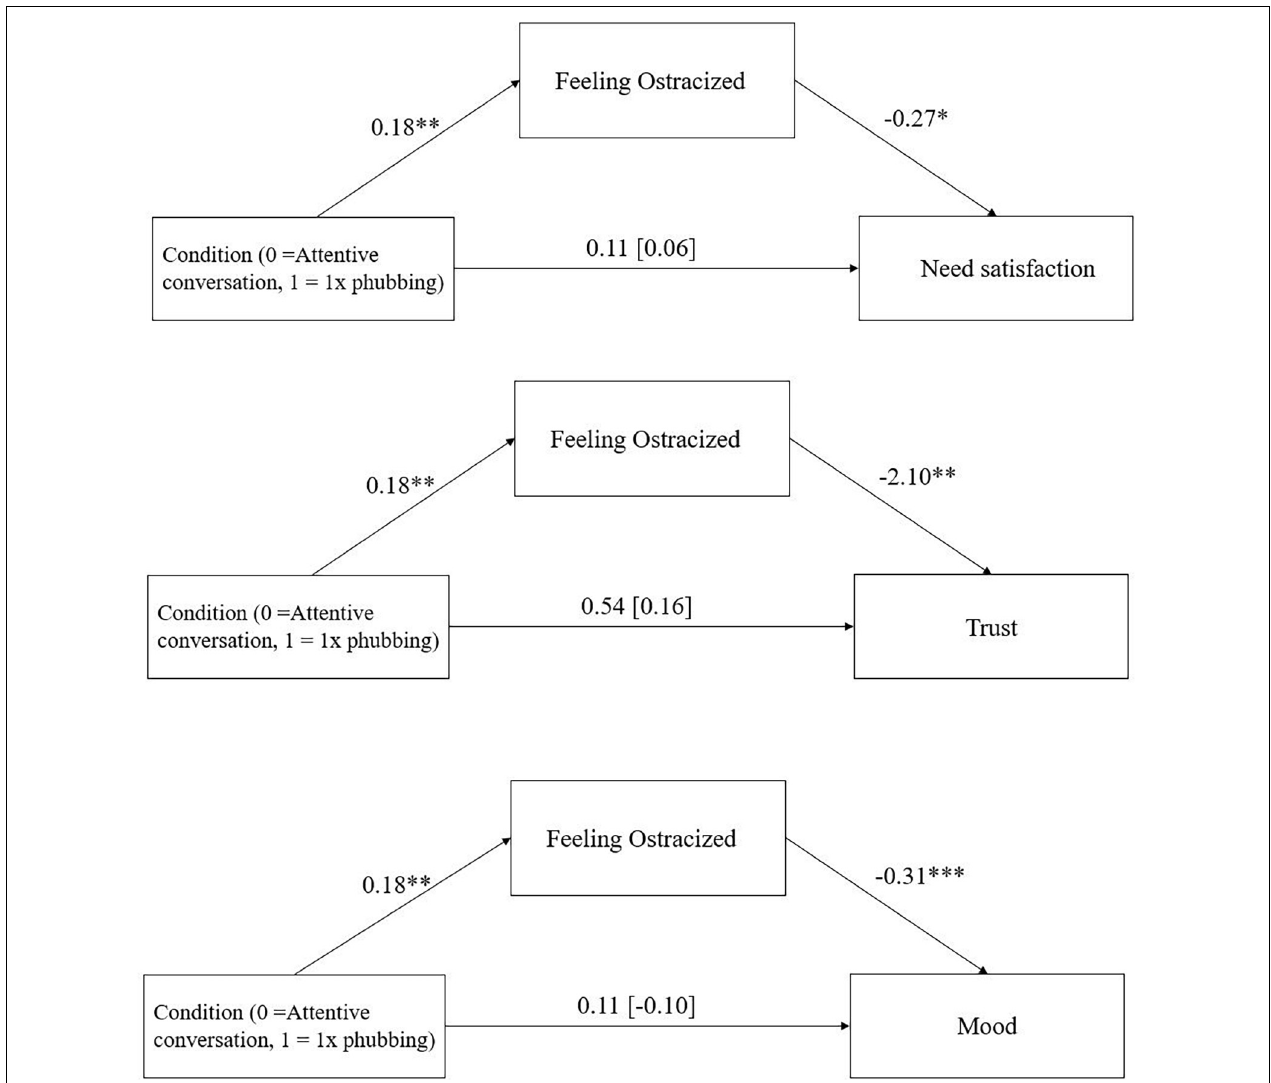
FIGURE 4 | Mediation effect of condition (attentive conversation vs. 1x phubbing) via feelings of ostracism on need satisfaction, trust in the trust game, and mood in Study 2 including the direct effect of condition on need satisfaction and mood (with total effect in parentheses). ∗ p < 0.05, ∗∗ p < 0.01, ∗∗∗ p < 0.001.